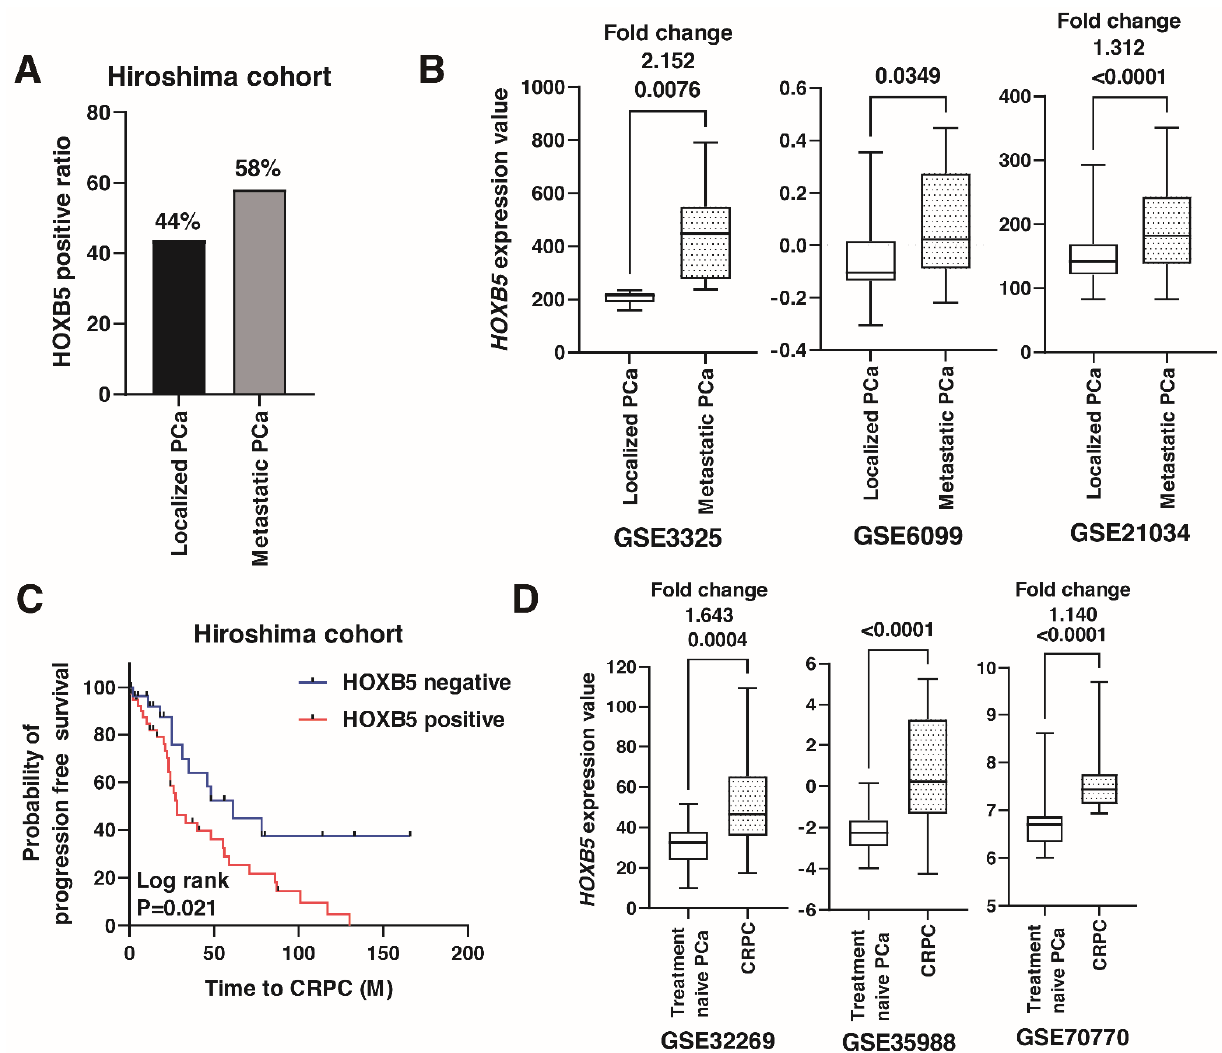
Figure 2. The expression of HOXB5 in metastatic prostate cancer (PCa). ( A ) The ratio of HOXB5-positive cases in localized and metastatic PCa from the Hiroshima cohort. ( B ) Box plot of HOXB5 expression in localized and metastatic PCa in GSE3325, GSE6099, and GSE21034. Fold changes are indicated. ( C ) Kaplan-Meier plot of progression-free survival of PCa patients with HOXB5 expression after androgen deprivation therapy from the Hiroshima cohort. ( D ) Box plot of HOXB5 expression in treatment naïve PCa and castration-resistant PCa (CRPC) in GSE32269, GSE35988, and GSE70770. Fold changes are indicated.